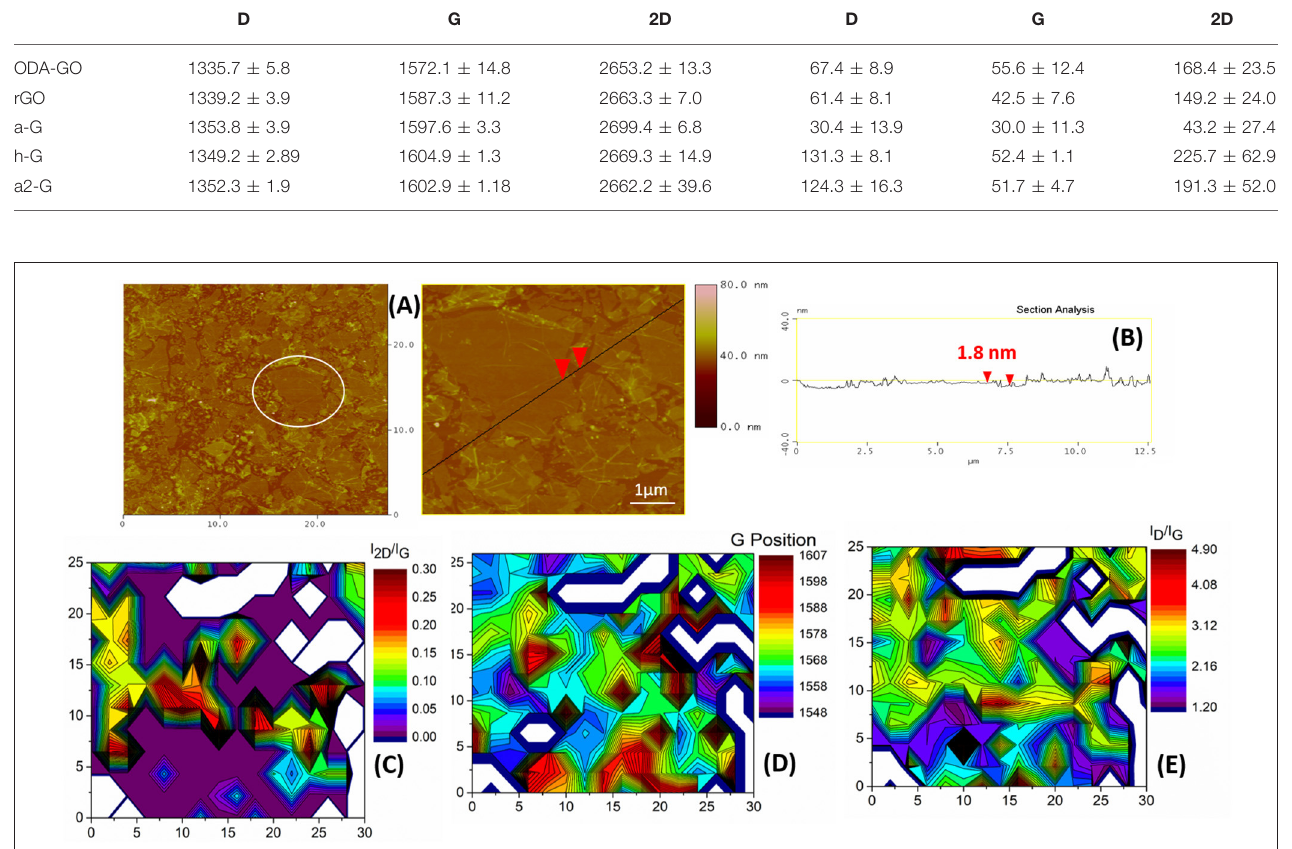
TABLE 1 | Characteristics of the Raman Vibrational modes as evaluated by the fitting procedure. Sample